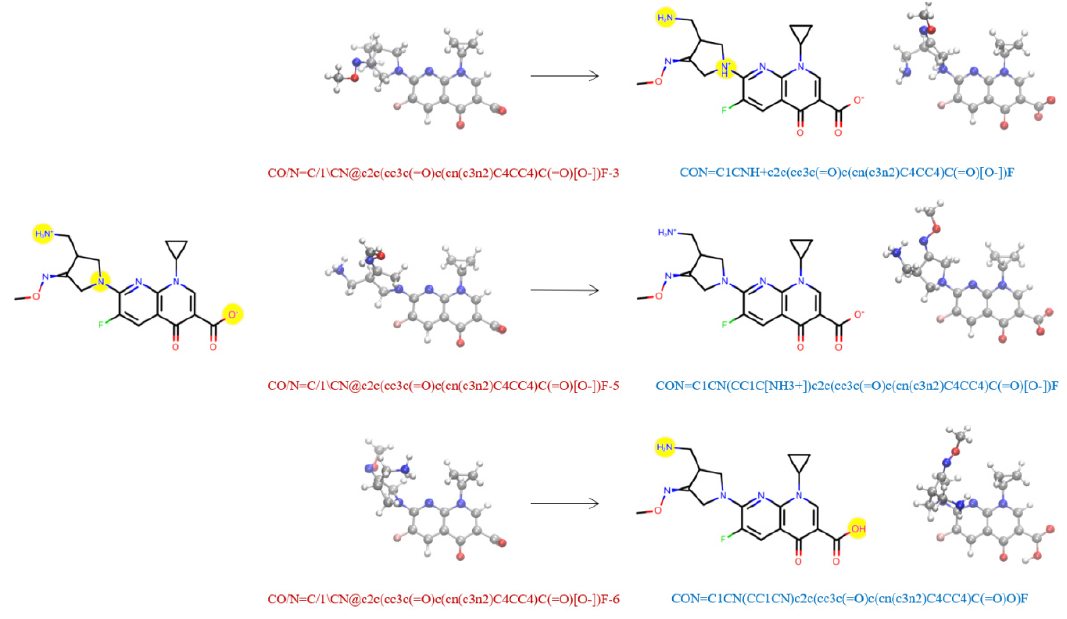
Figure 1. Molecules may change connectivity during QM optimization leading to different tautomers. On the left hand side, we show the Lewis structure and three associated conformers of an example molecule from the QCArchive OpenFF Full Optimization Benchmark 1 dataset. Yellow circles highlight the regions of potential tautomerization changes. The QCArchive SMILES labels are colored in red. The right hand side shows the structures after QM optimization. The canonical isomeric SMILES labels representing the optimized molecules are colored in blue. Only the middle structure retains the original tautomeric identity. In our dataset, the geometries on the right hand side would be analyzed as distinct